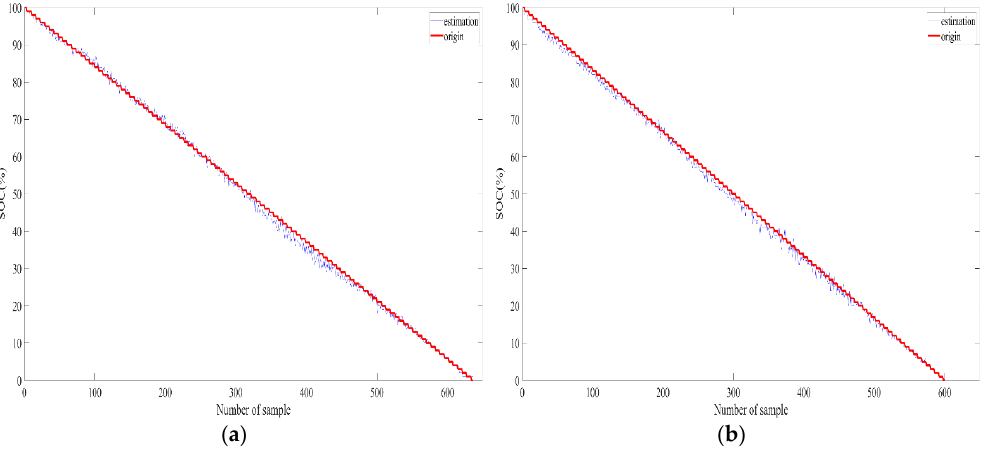
Figure 10. SOC estimation results; ( a ) using the MNN utilizing only 6 voltage as the input value and the temperature variable data at room temperature; ( b ) using the MNN utilizing only 6 voltage as the input value and the temperature variable data at high temperature.